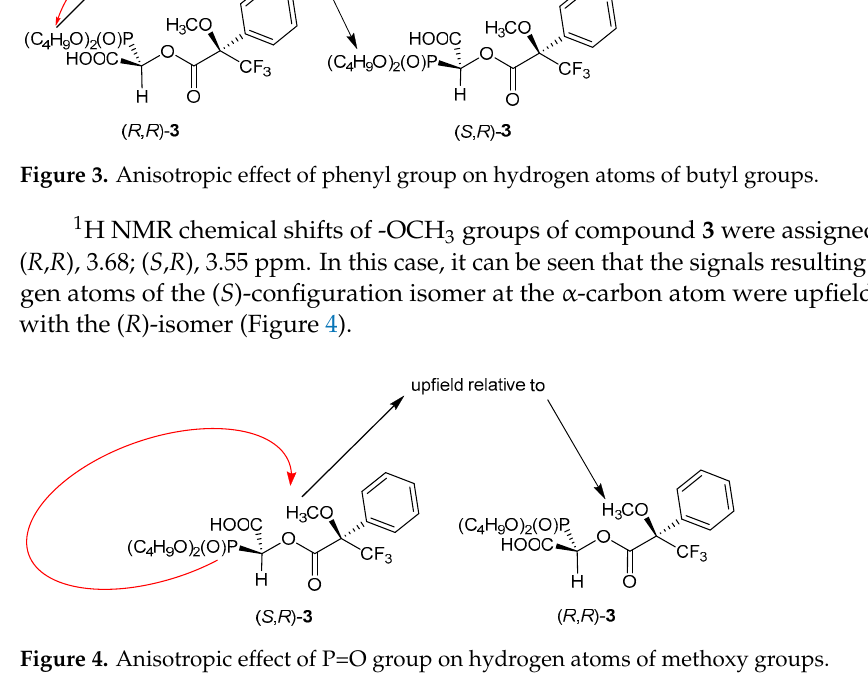
Comparison of all spectra allowed for assignment of the absolute configuration of